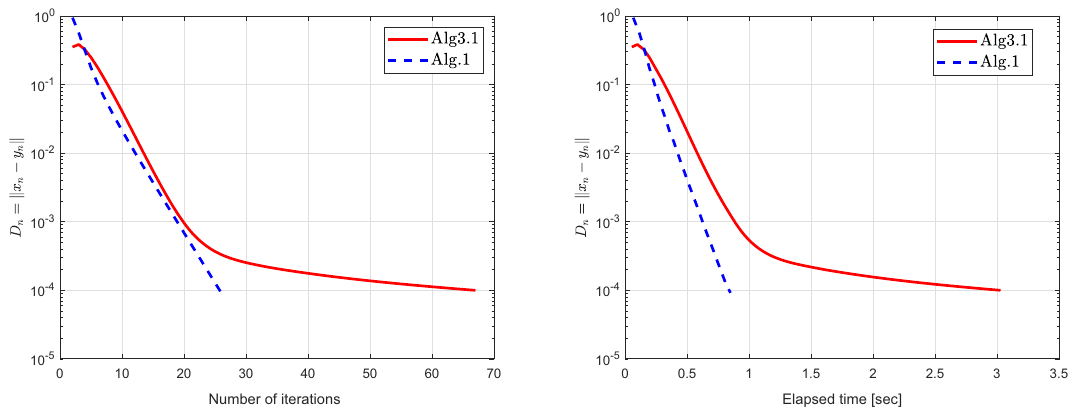
Figure 5: Example 6.2: Comparison of Algorithm 1 with Algorithm 3.1 in [ 31 ] . Comparison by using ( ) = x 1, 1, 1, 1, 1 T 1 .